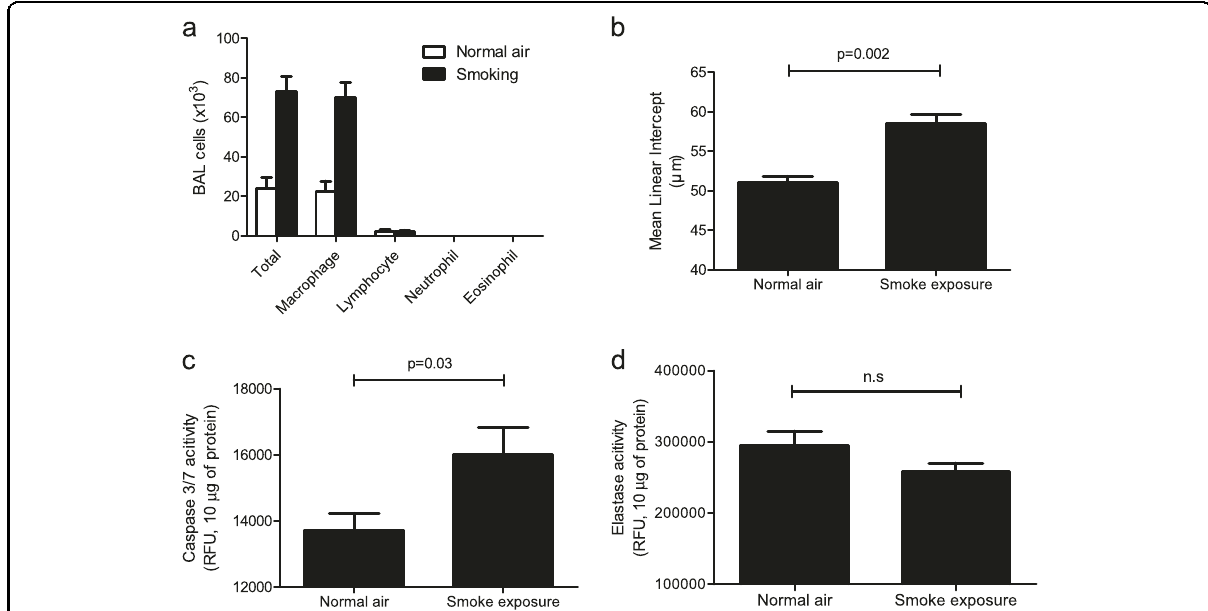
Fig. 2 Characterization of short-term exposure to cigarette smoke. a – d The mice were exposed to cigarette smoke for 4 days using an inhalation box. a Cellularity in bronchoalveolar lavage (BAL) fl uid. P < 0.0001 using two-way analysis of variance. b Mean linear intercept (MLI) ( n = 6 per group). c Caspase-3/7 and elastase activities were measured in 10 μ g of lung lysate ( n = 11 per group). P -values were determined by the